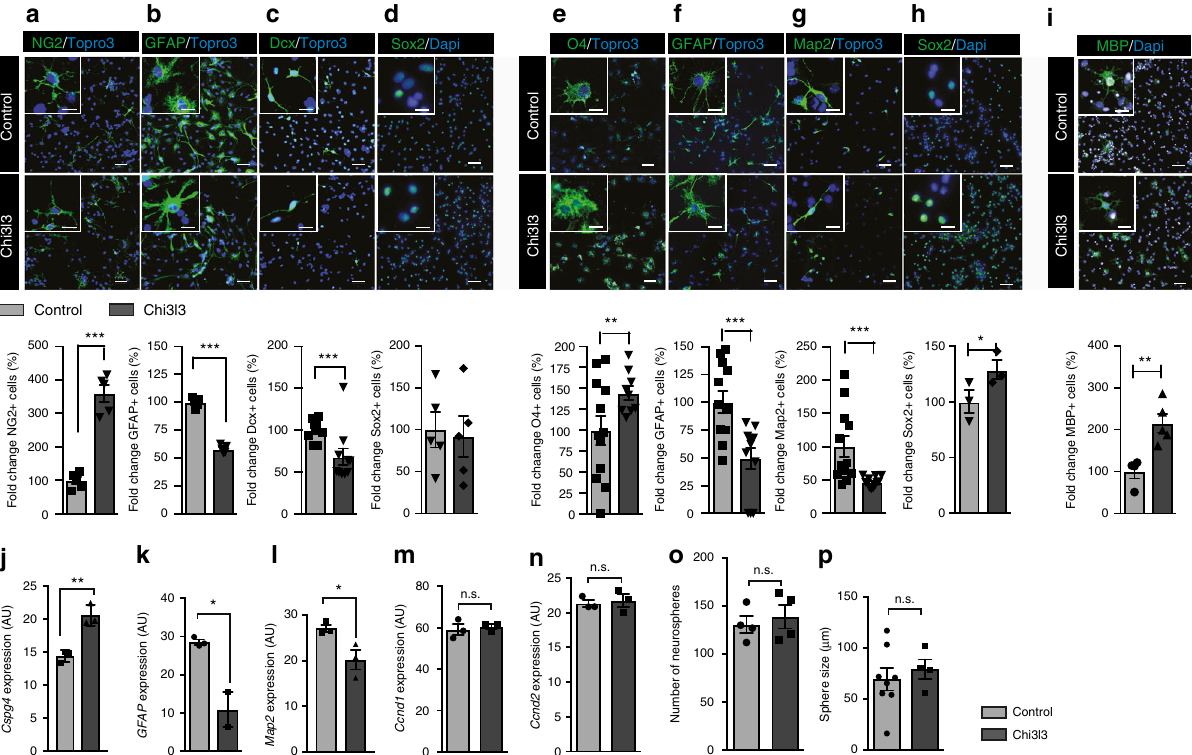
Fig. 2 Chi3l3 directly promotes oligodendrogenesis in vitro. Representative confocal image (above) and quanti fi cation (below) of neural stem cells (NSCs) cultured in the presence of PBS (control) or Chi3l3 (100 ng/ml) for 3 days a – d , 5 days e – h , or primary OPCs cultured in the presence of PBS (control) or Chi3l3 (500 ng/ml) for 7 days i . Cells were treated with the nuclear stain TO-PRO-3 (blue) and immunostained for early progenitor markers NG2 ( a ; oligodendrocyte precursor cells, green), GFAP ( b ; astrocytes, green), Dcx ( c ; neuroblasts, green), late progenitor markers O4 ( e ; oligodendrocytes, green), GFAP ( f ; astrocytes, green) and microtubule-associated protein 2 ( g ; Map2, neurons, green), the neural stem cell marker Sox2 ( d , h ; green) and the myelin protein MBP ( i , oligodendrocytes, green). Exposure of differentiating NSCs to Chi3l3 led to signi fi cant increase in oligodendrocyte precursor cells and oligodendrocytes, signi fi cant decrease in astrocytes, neuroblasts, and neurons and a signi fi cant increase in Sox2 + neural stem cells. Scale bar, 50 μ m. Inserts show representative cells. Scale bar, 20 μ m. j – n Gene expression of Cspg4 (NG2; j ), Gfap k , and Map2 ( l ; 3 days) and Ccnd1 and Ccnd2 ( m , n ; 24 h) mRNA in PBS (control) or Chi3l3-treated differentiating NSCs. Values were normalized against Gapdh (AU, arbitrary unit; n.s., not signi fi cant;). Number o and size p of neurospheres from NSCs exposed to Chi3l3 or PBS (control). (n.s., not signi fi cant; two-tailed Student ’ s t test; data are representative of three independent experiments with n = 5 replicates a , c , d , i , n = 9 (Control) and 10 (Chi3l3) replicates b , n = 12 (Control) and 9 (Chi3l3) replicates e , n = 12 replicates f , g , n = 3 replicates h , j , l , m , n ), n = 3 (Control) and 2 (Chi3l3) replicates k , n = 4 replicates o , n = 8 (control) and four (Chi3l3) replicates p ). mean ± s.e.m. * p < 0.05; ** p < 0.01; *** p < Chi3l3-induced Olig2 expression (Fig. 3e, g). In line with our results from pharmacological inhibition, knockdown of Ptk2b (Supplementary Figure 6A) and overexpression of dominant- negative Erk2-K54R (Supplementary Figure 6B) resulted in signi fi cantly decreased Chi3l3-induced Olig2 expression (Fig. 3f, h).